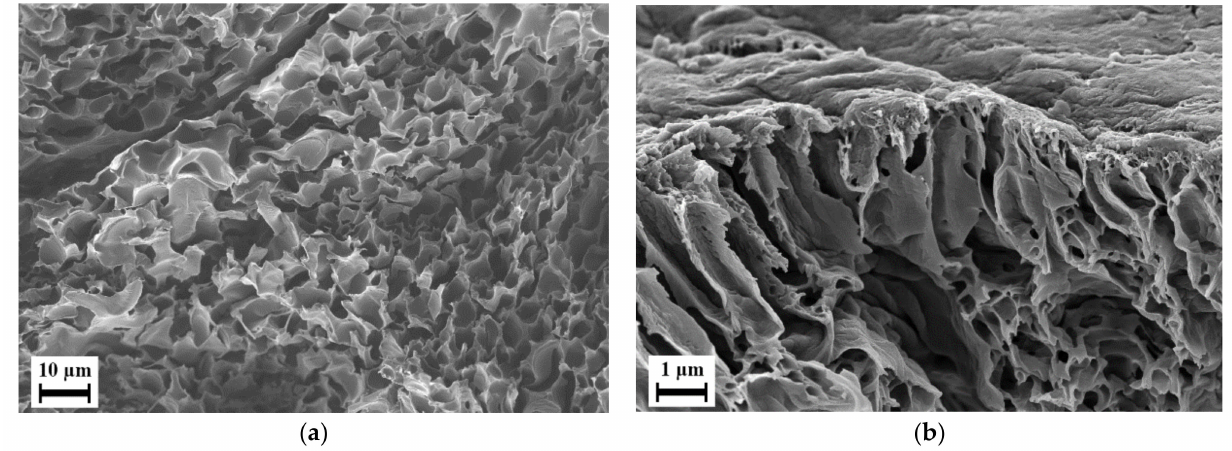
Figure 3. Scanning electron micrograph of PESU E 3020 P flake: ( a ) cross-section, ( b ) surface